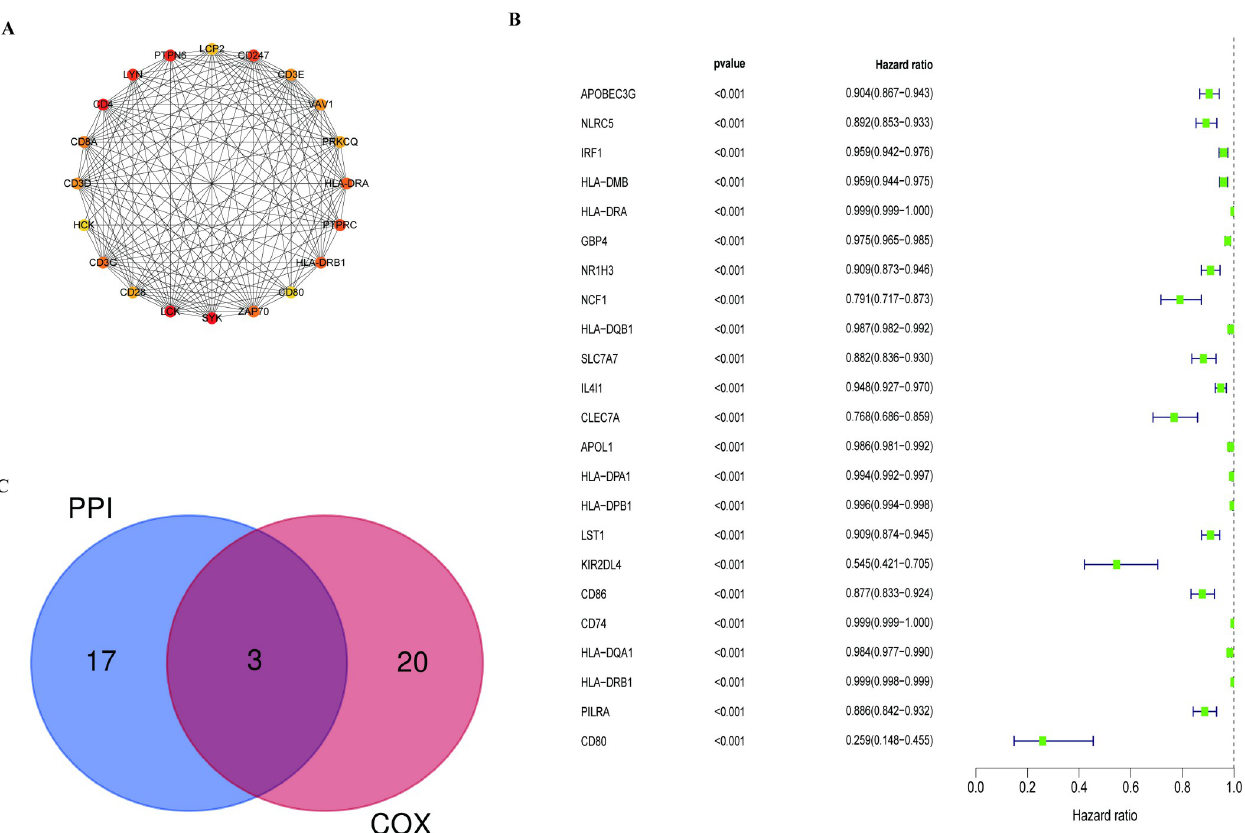
Fig 5. Protein–protein interaction network analysis and univariate Cox regression analysis. (A) The network of top 20 hub genes with high connectivity degree in the PPI network. (B) The Forest map represented the result of the univariate Cox regression analysis. (C) Venn plot showed the intersection part of the result of the PPI network and univariate Cox regression